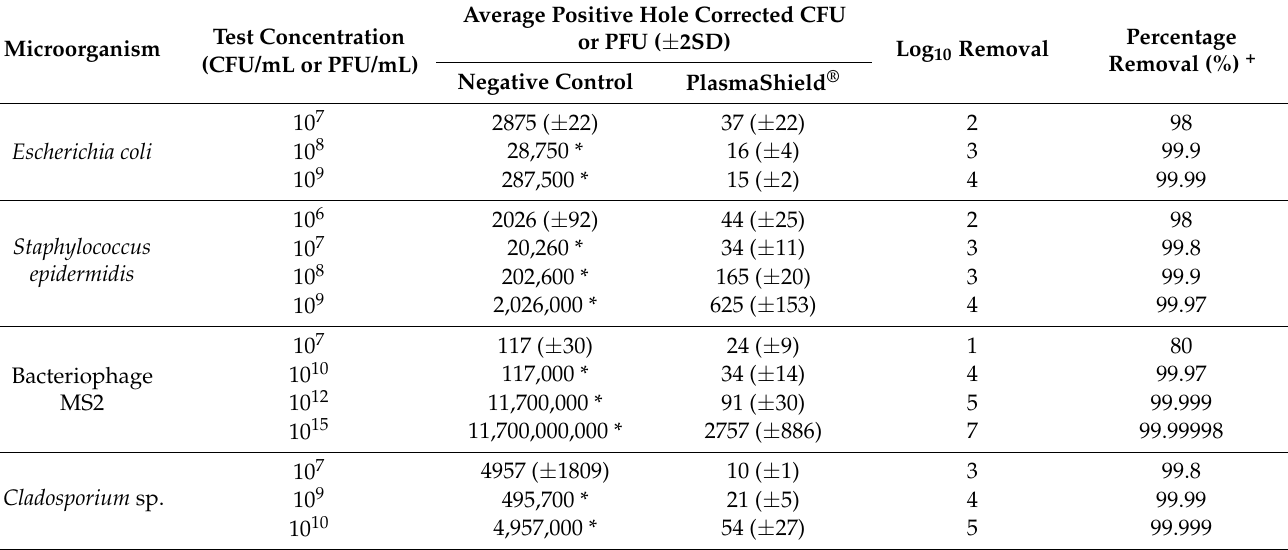
Table 1. Removal efficacy of the PlasmaShield ® compared with the negative control for each microor- ganism and concentration